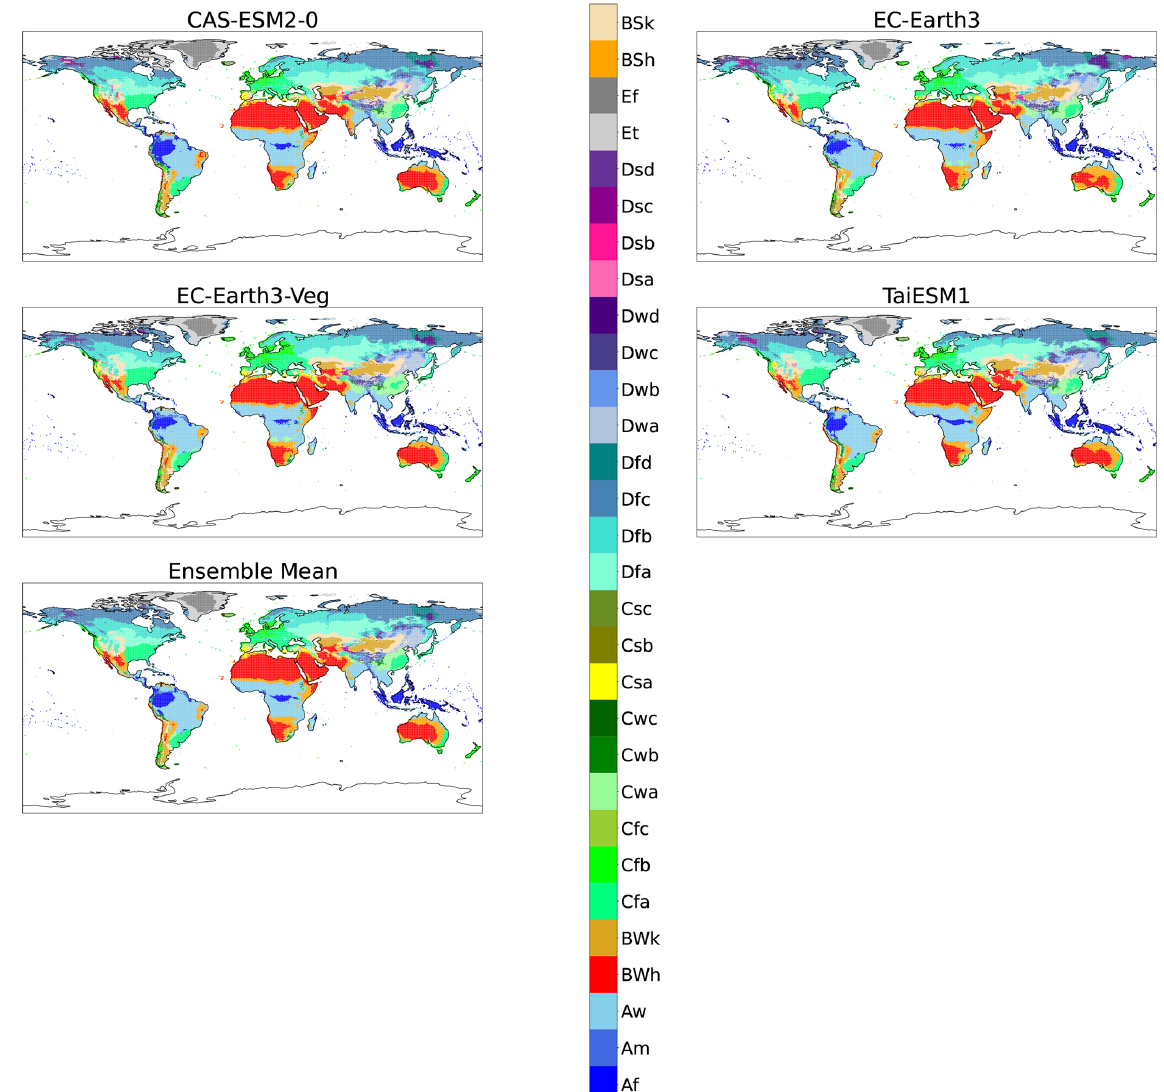
Figure A5. Maps of KG classifications for each model at + 3K with anomaly